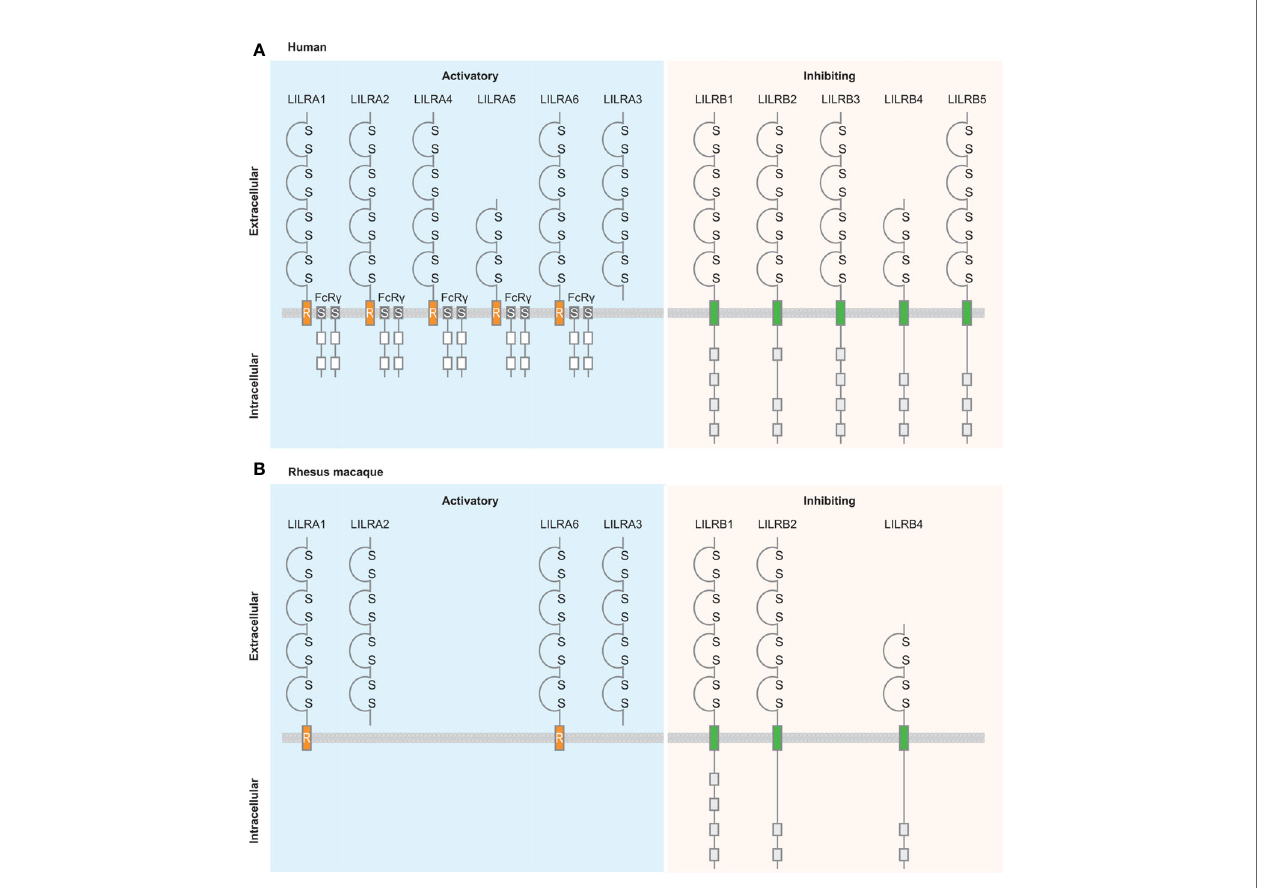
FIGURE 7 | Schematic illustration of the structure of LILR family members in human and rhesus macaque. A structural comparison between LILR family members in humans (A) and rhesus macaques (B) (112). LILR receptors are classi fi ed based on the presence or absence of the transmembrane region and the cytoplasmic tail. Activating receptors associate with the g -chain of Fc receptors, while the inhibitory receptors contain cytoplasmic immunoreceptor tyrosine- based inhibition motifs. Based on the conserved nature of the LILRA receptors it is plausible that also in rhesus macaque these types of receptors associate with FcR g , however, because this is not of fi cially documented it is not illustrated in the fi gure. LILRA3 is a soluble receptor lacking the transmembrane region and cytoplasmic tail. Ig-like domains are indicated by a domain structure containing disul fi de bridges; transmembrane region is indicated by orange boxes including an R, which refers to the presence of the positively charged arginine residue, for the activating LILR receptors and by green boxes for the inhibitory LILR receptors; Fc receptor transmembrane by dark grey boxes containing an S; immunoreceptor tyrosine-based activation motifs by white boxes; and immunoreceptor tyrosine-based inhibition motifs by light-grey